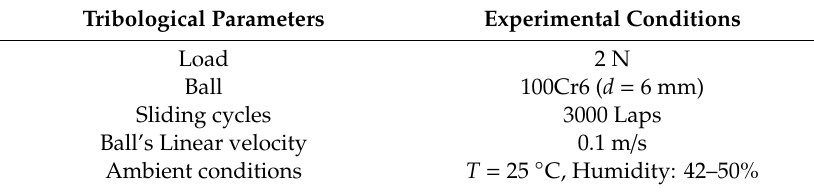
Table 2. Experimental conditions for the tribological study of composite Sn–Ni / doped-TiO 2